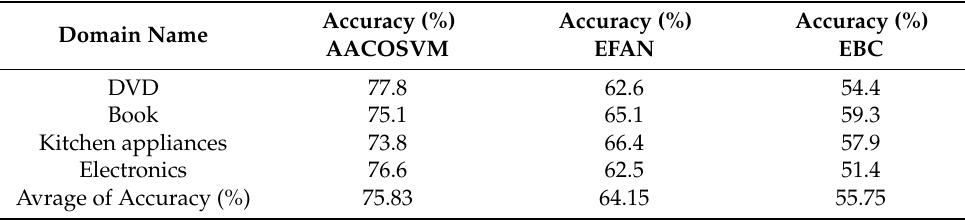
Table 3. Comparative Analysis of